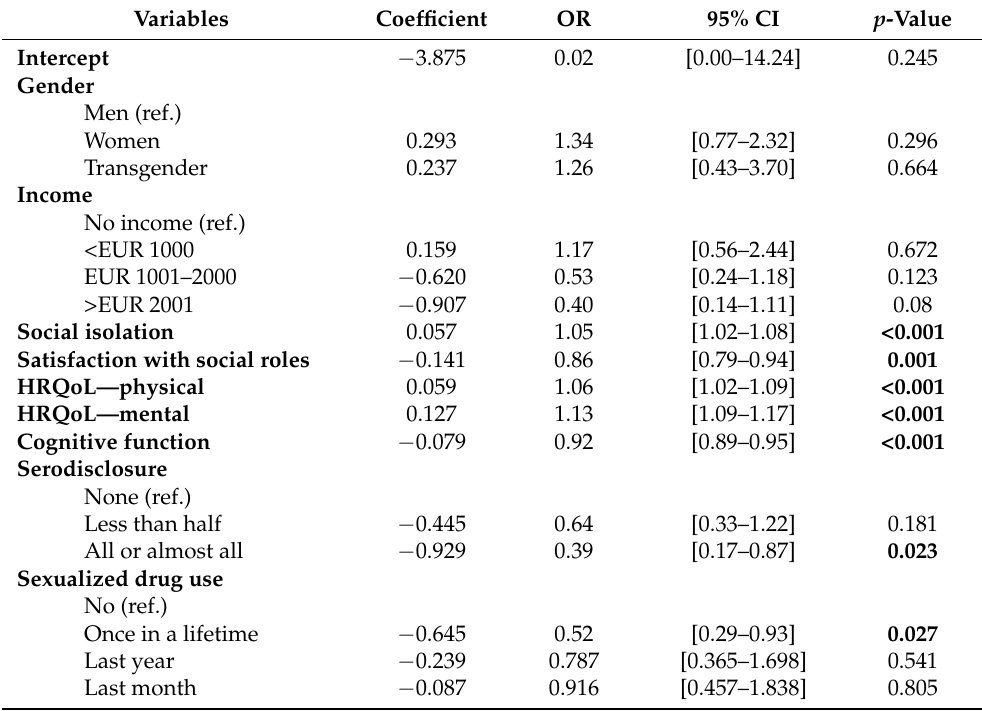
Table 3. Final model from the regression analyses, with depression symptoms as the outcome variable in the total